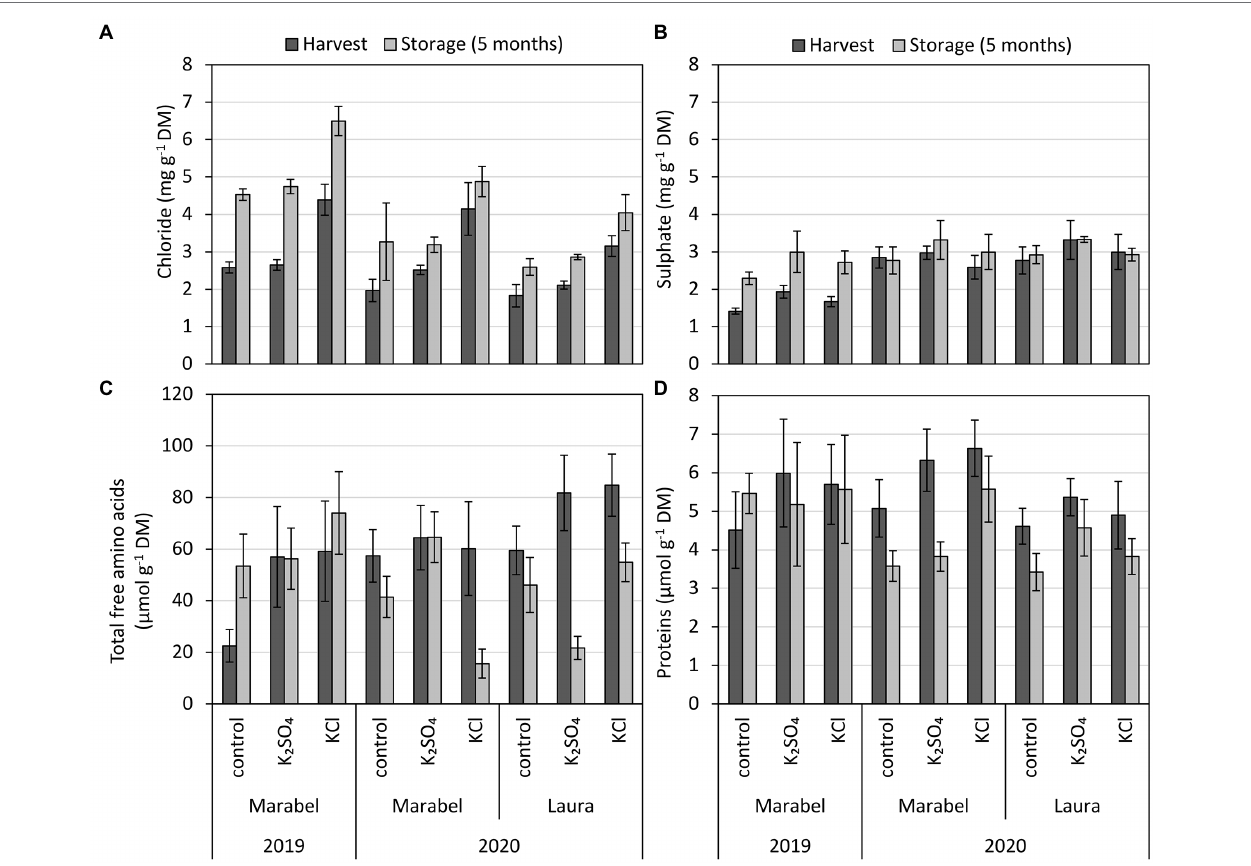
FIGURE 2 | (A) Chloride, (B) sulphate, (C) total free amino acids, and (D) protein concentration of entire tubers depending on year, cultivar, fertilisation form, and storage. Mean ± SD ( n = 4). *, **, and *** for p < 0.05, 0.01, and 0.001, respectively. n.s., Not significant. Effect of year considers differences of tubers after harvest between 2019 and 2020 for Marabel, cultivar effects describe differences between Laura and Marabel in 2020, and storage effects refer to data of both cultivars and both years. Chloride: fertilisation***, year n.s., cultivar n.s., storage***; sulphate: fertilisation n.s., year***, cultivar n.s., storage***; amino acids: fertilisation**, year n.s., cultivar***, storage**; and proteins: fertilisation***, year n.s., cultivar*,